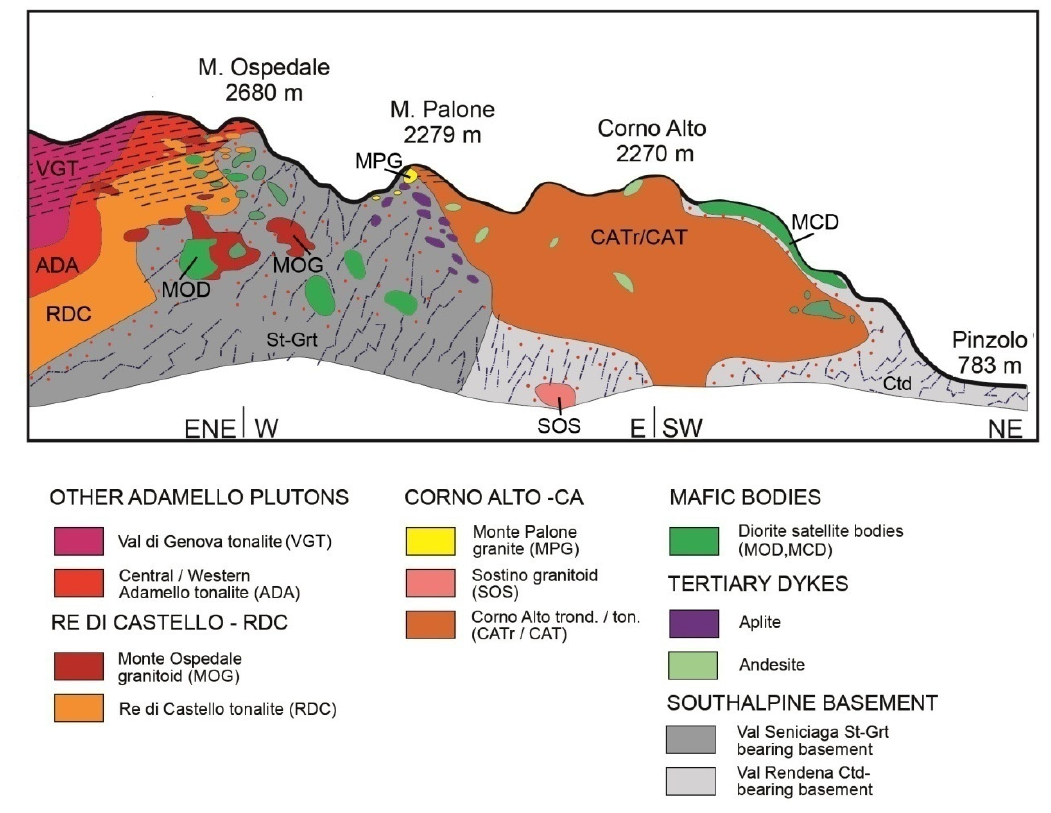
Figure 4. Geological section across Corno Alto–M. Ospedale. Intrusive relationships between diorite apophyses and dykes (green colour), RDC foliated leuco-tonalite (orange), Central/Western Adamello ADA (red), Val di Genova tonalite (violet) and leucogranites (dark red). Straight dashed lines indicate tectonic foliation, purple dashed lines indicate Variscan basement schistosity and red dots identify contact metamorphism. Profile trace is shown in Figure 3.